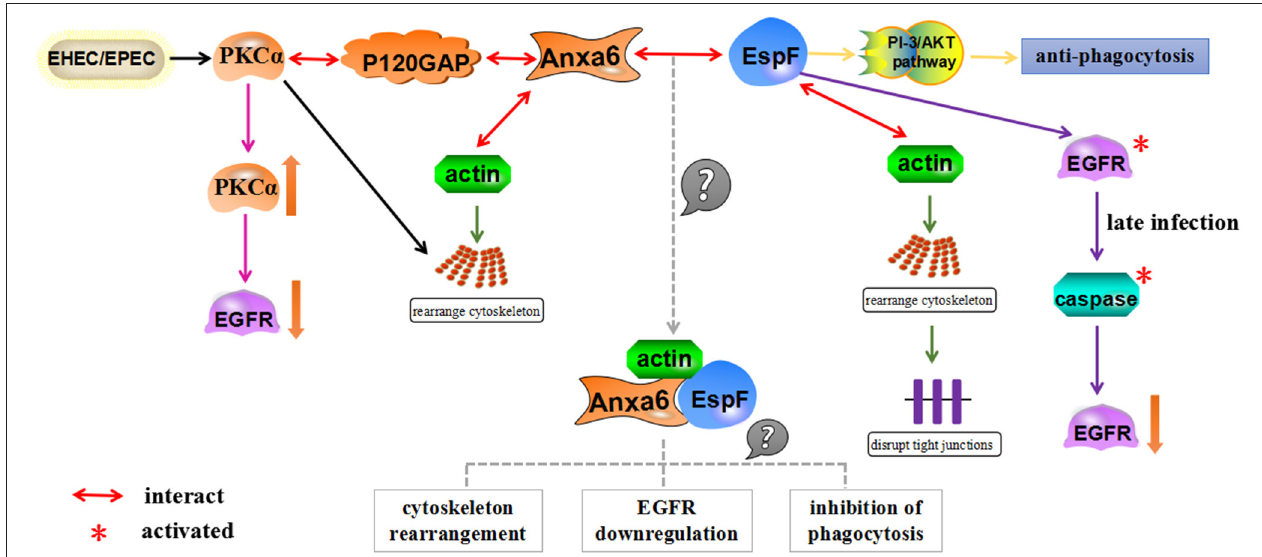
FIGURE 4 | A schematic model for how EspF and Anxa6 protein potentially mediate anti-phagocytosis. Anxa6 collaborates with actin to cause cytoskeletal rearrangement, forms complexes with PKC α and P120GAP, and downregulates EGFR levels. Similarly, EspF combines with actin to regulate the rearrangement of the actin cytoskeleton in host cells, exerts anti-phagocytosis through the PI-3/AKT pathway, and leads to a decrease in EGFR levels through activation of caspase in late infection. EspF and Anxa6 may form complexes with actin, which act together to mediate cytoskeleton relocation, EGFR downregulation, and anti-phagocytosis.